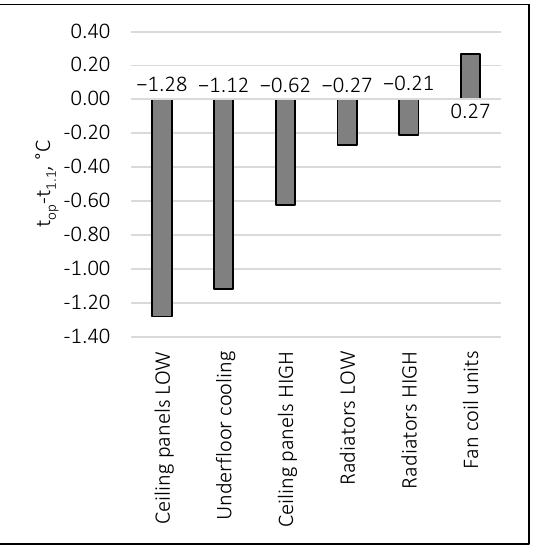
Figure 11. Measured difference between operative and air